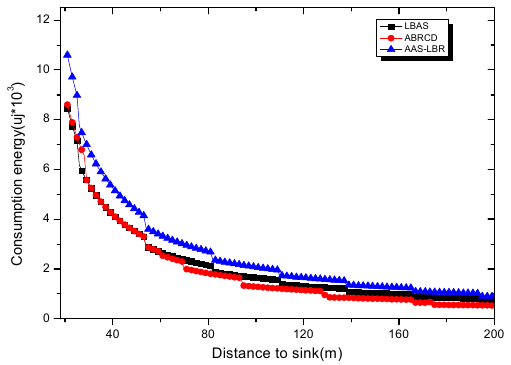
Figure 26. Energy consumption of nodes 20–200 m away from sink under 𝑇 = 20 and r = 28 m .